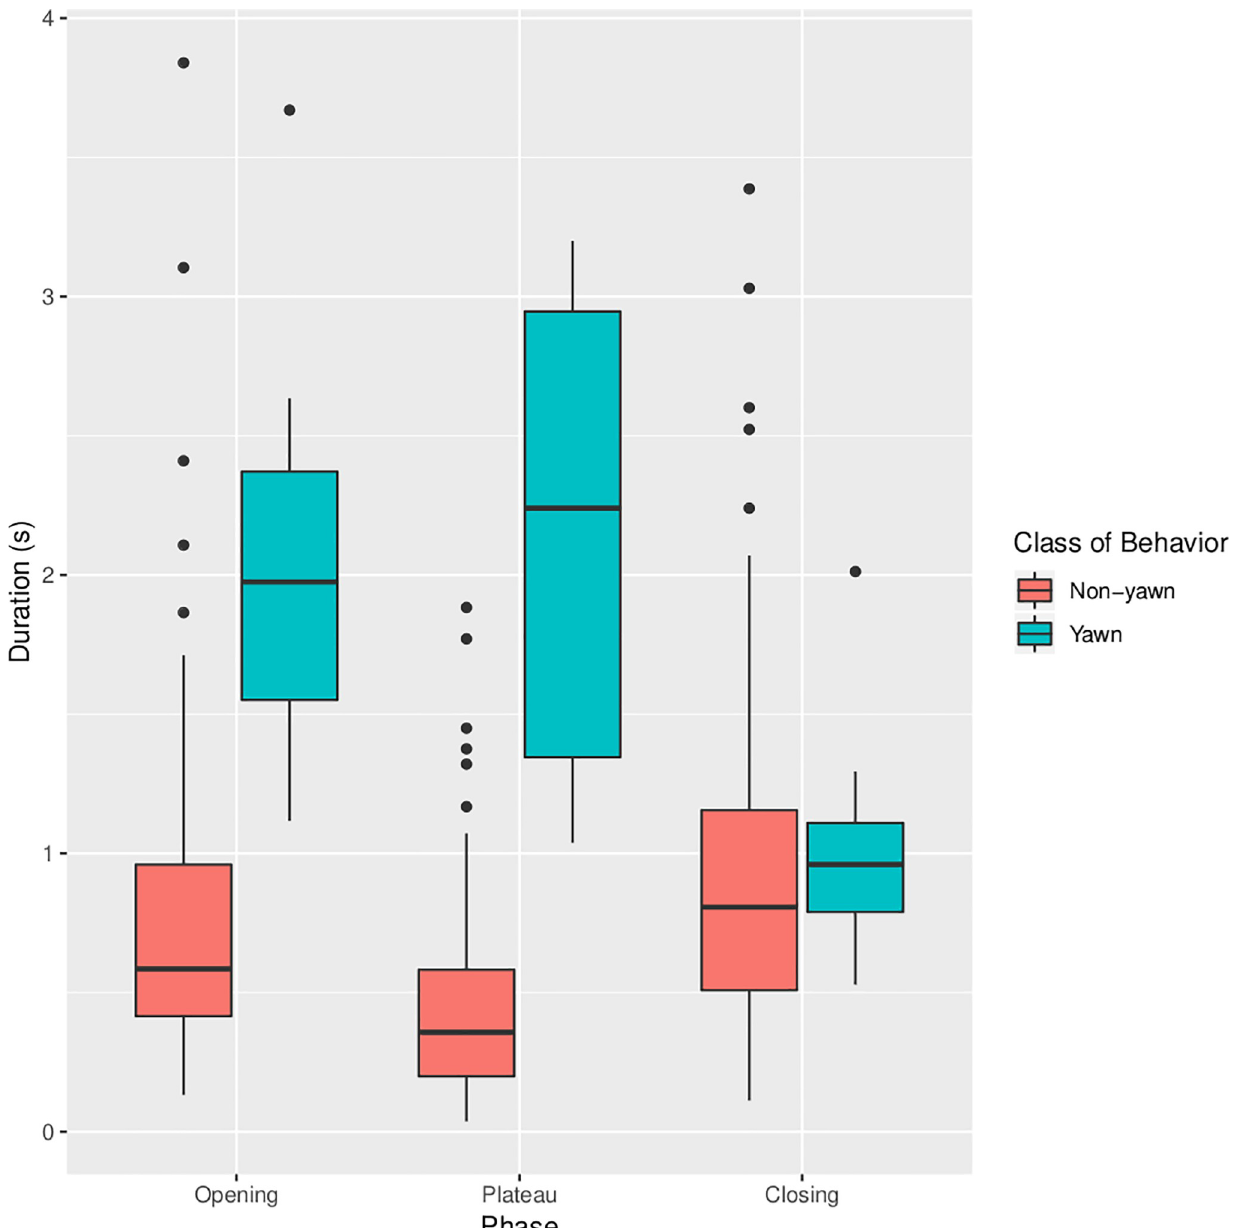
Fig 1. Temporal dynamics of yawning and non-yawn mouth openings. Box plot of the duration of the opening, plateau and closing phases of yawn and non-yawn mouth openings. The lower and the upper hinges represent, respectively the first and third quartiles; the whiskers extend from the hinges to the most extreme value no further than 1.5 � from the hinge. Points represent